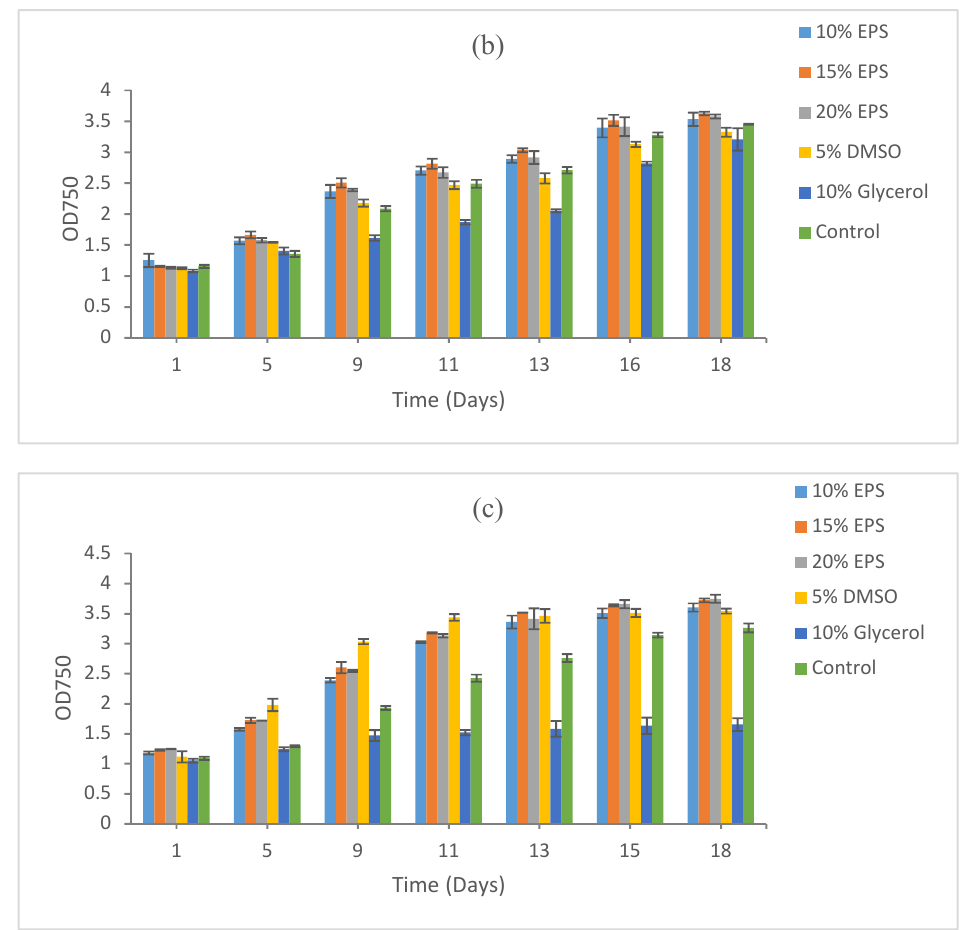
Figure 3. Growth recovery for Microcystis aeruginosa PCC7806 after cryopreservation for ( a ) 5 days, ( b ) 15 days, and ( c ) 9 months. Duplicate samples were measured. The images of cultures at the end points refer to Figure S6.